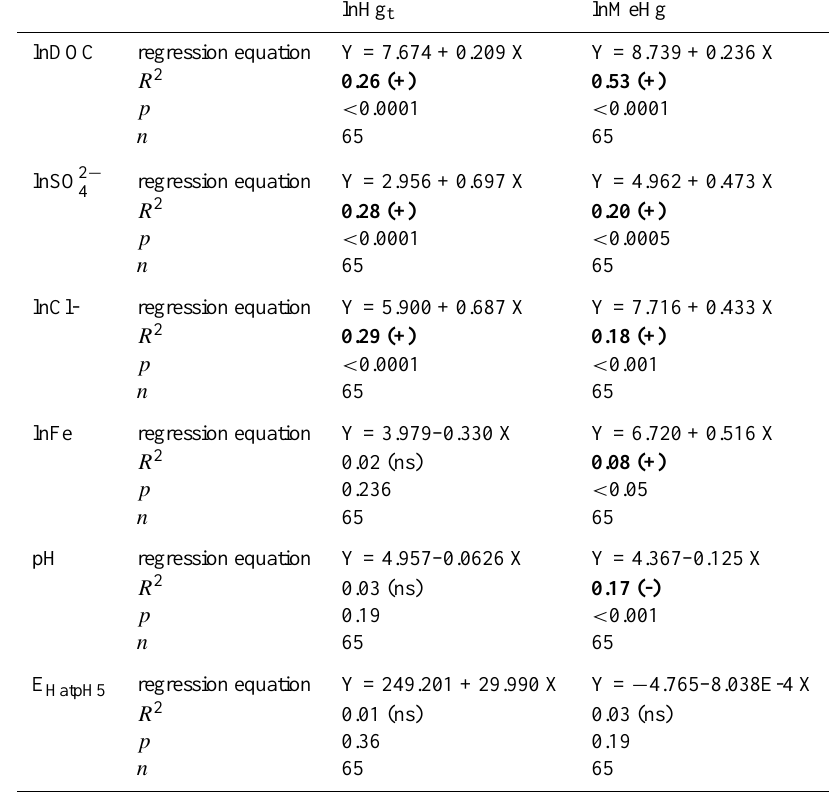
Table 3. Regressions between total mercury (Hg t ) resp. methyl mercury (MeHg) vs. anions (Cl − , SO 2 − soluble fraction. (+) positive relationship; (-) negative relationship; ns = not significant with p ≥ 0 . 05.